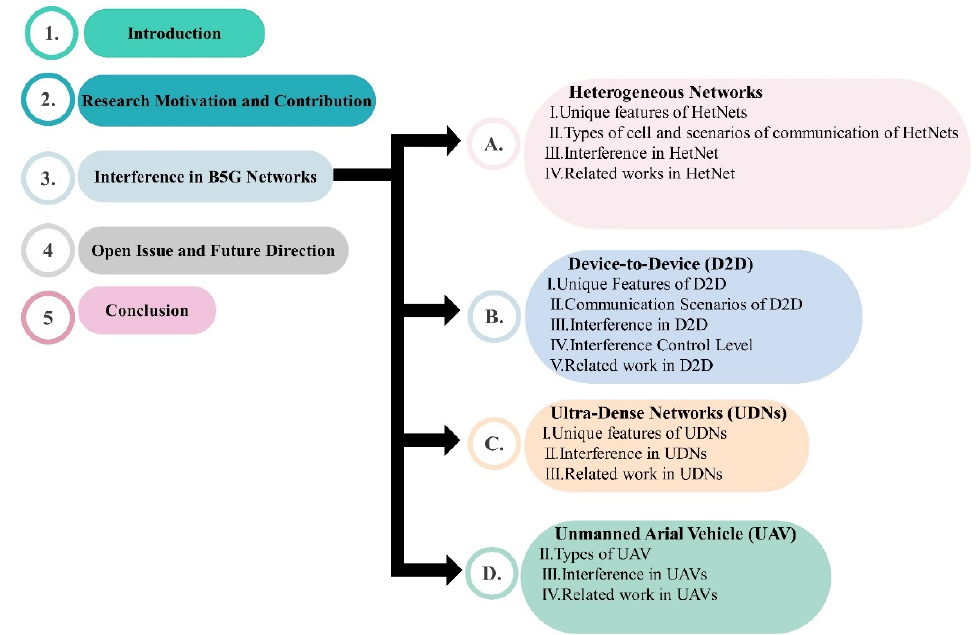
Figure 1. The organization of the Paper.